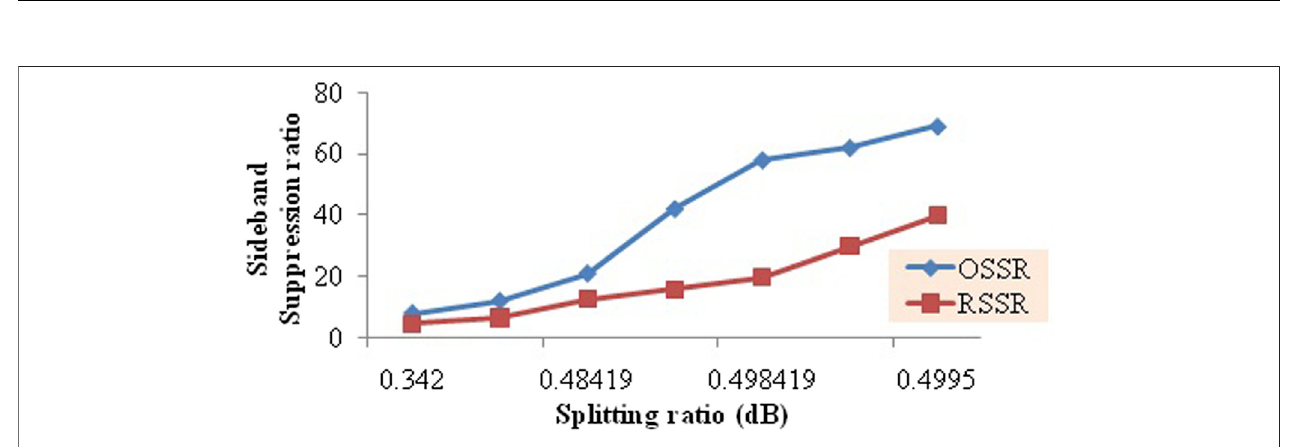
FIGURE 6 | Impact of the splitting ratio on the sideband suppression